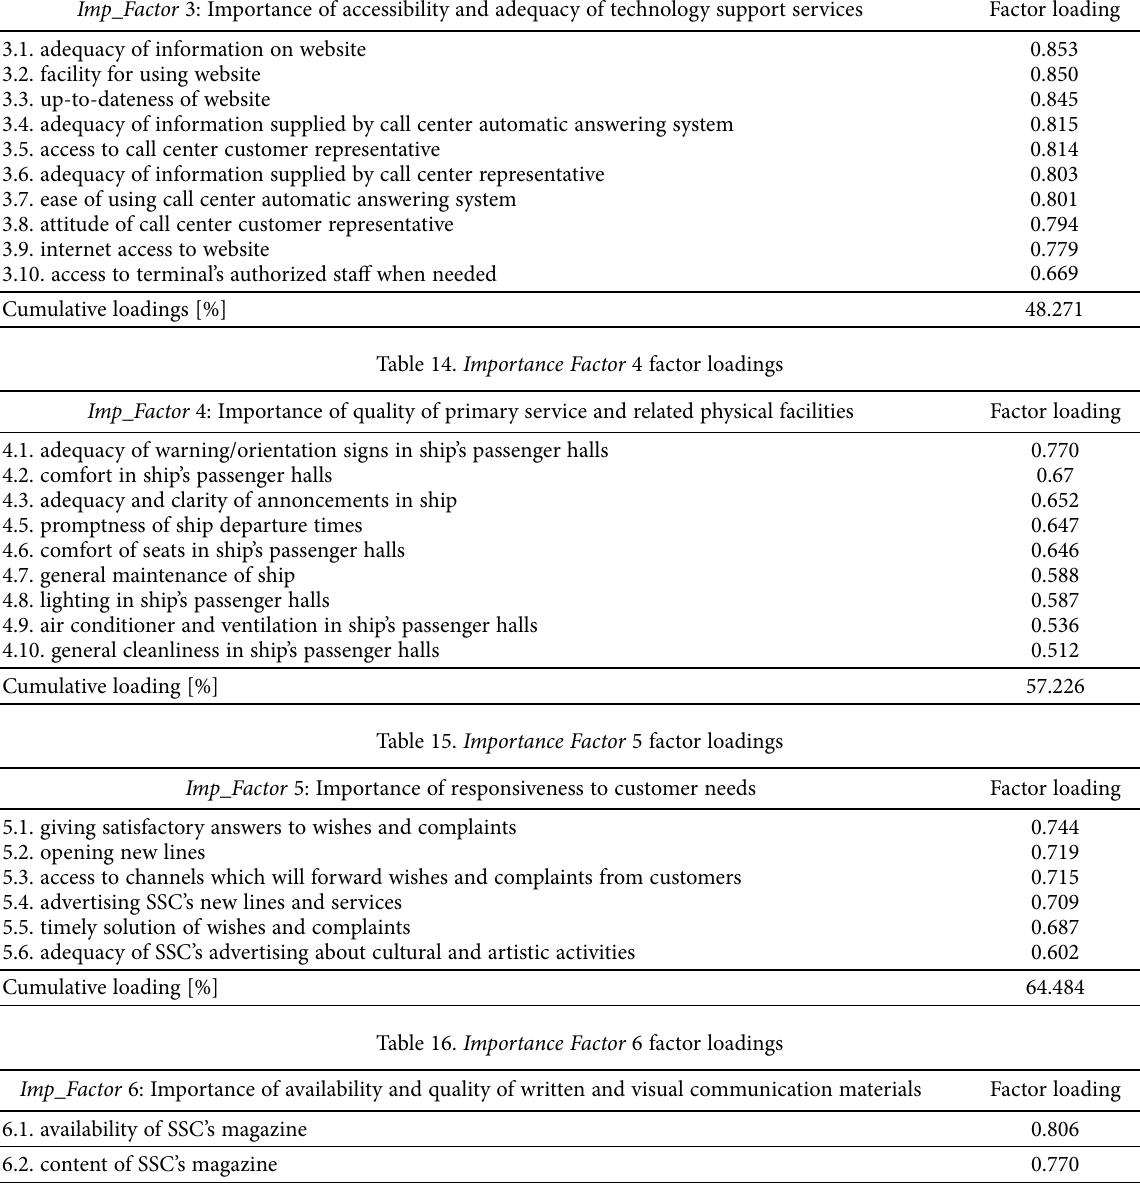
Table 13. Importance Factor 3 factor loadings